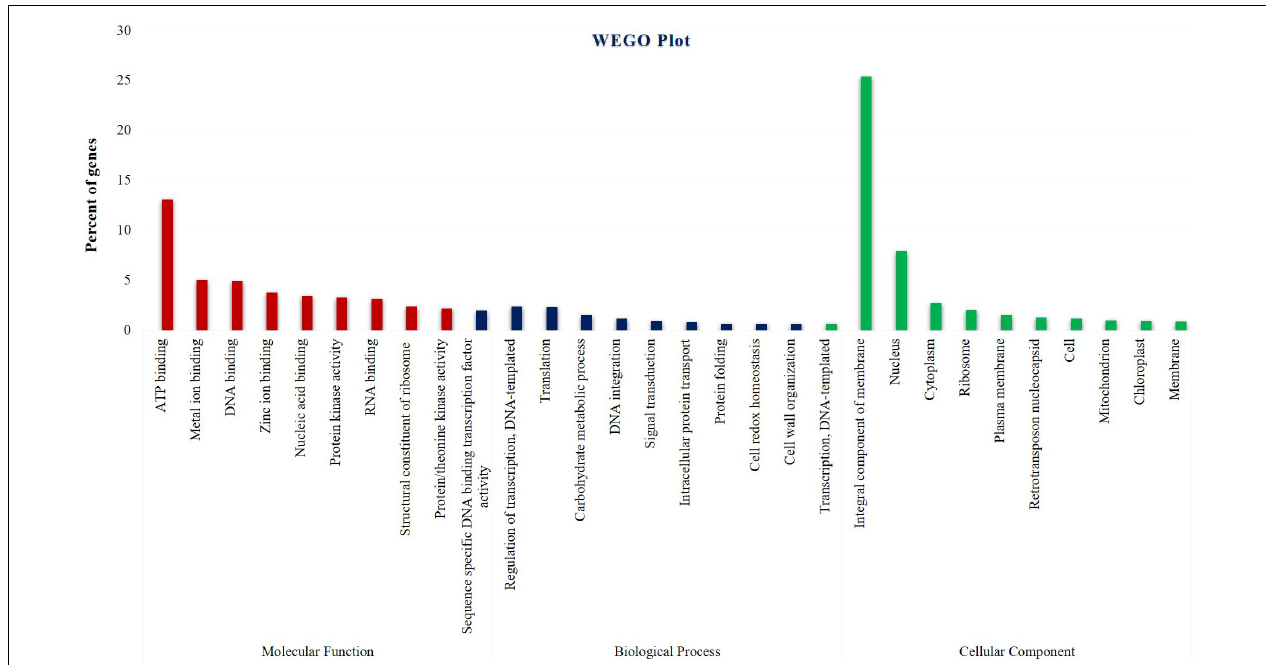
FIGURE 2 | Pie chart shows drought-stressed cluster bean cultivar RGC-1025 Gene Ontology classification of transcripts into biological process, molecular functions, and cellular components.